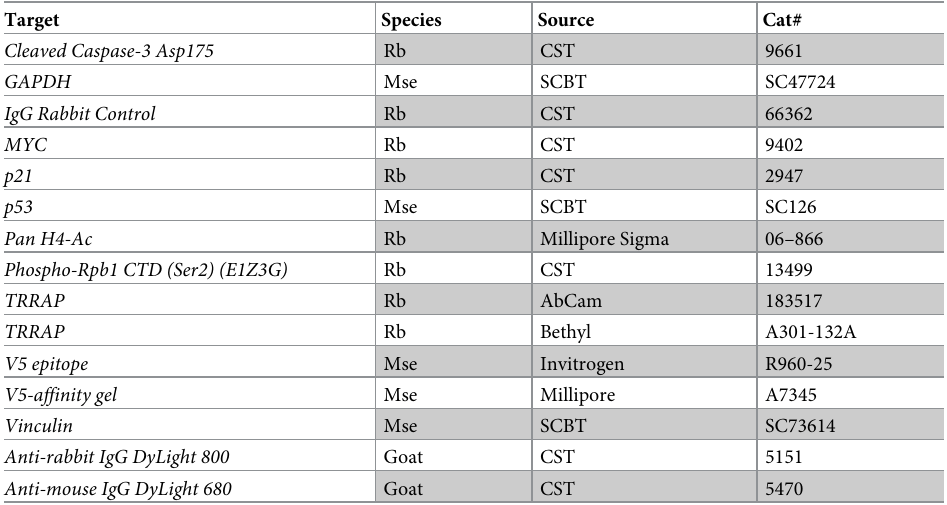
Table 1. Antibodies used for western